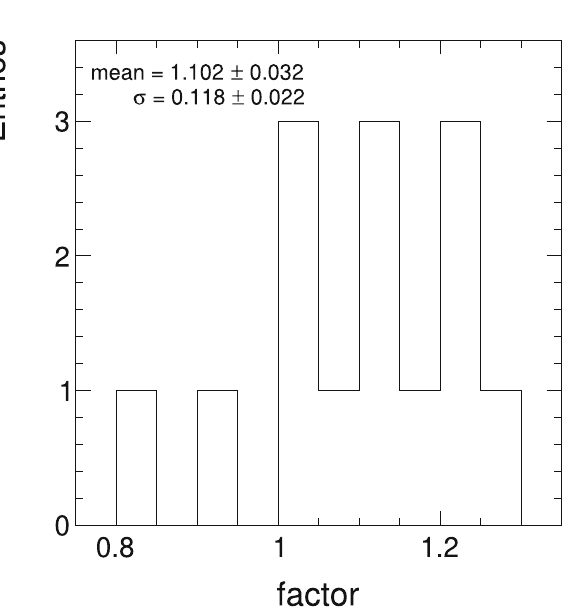
Fig. 55 Distribution of factors between data and global interpolation for the spectrometer experiments Sects.